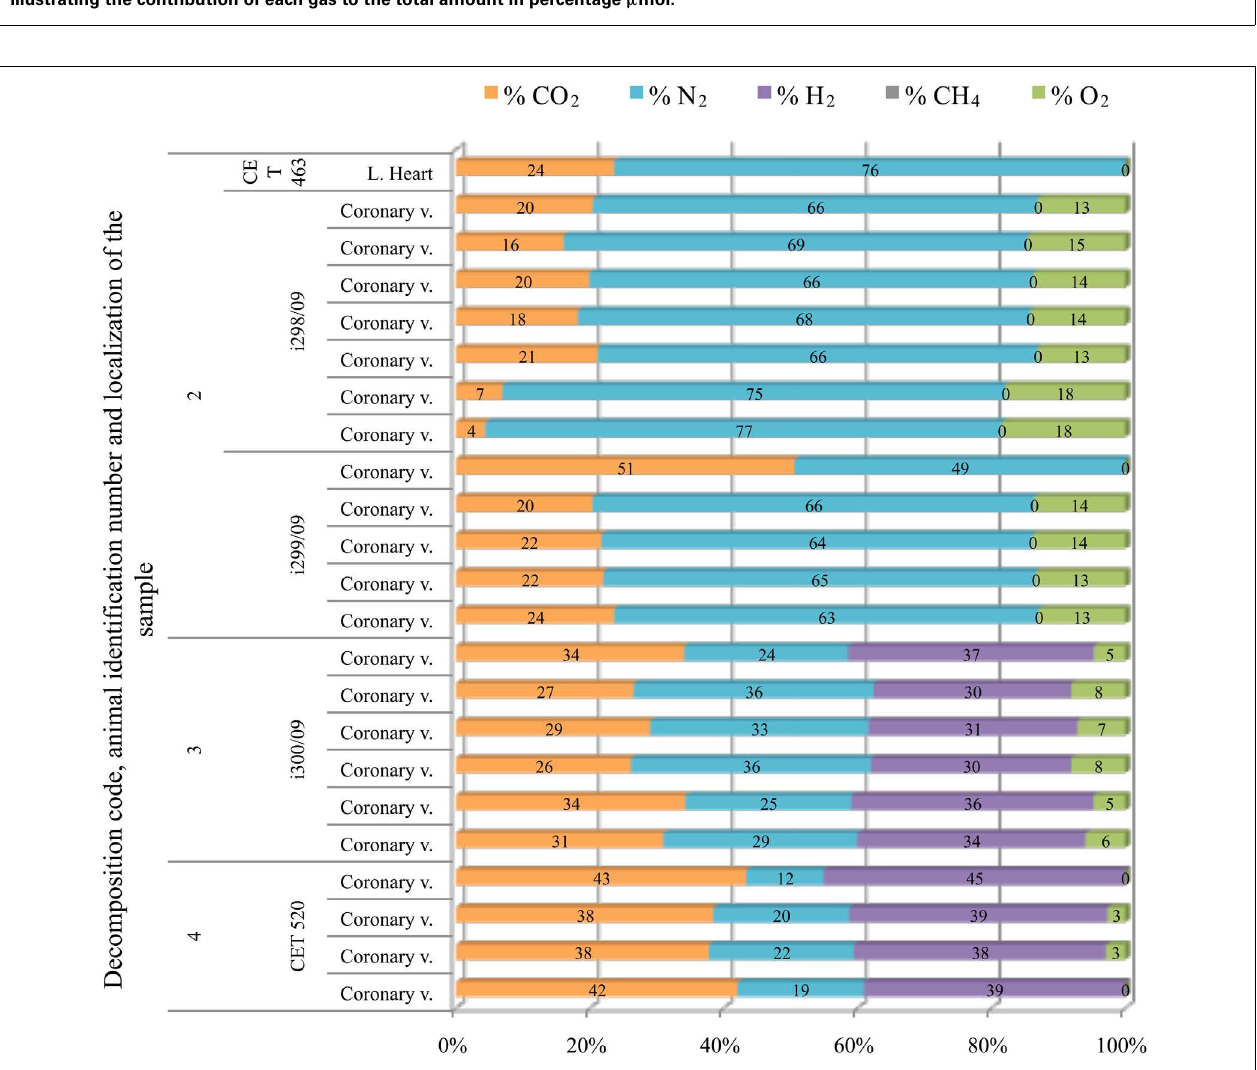
FIGURE 8 | Intravascular bubble’s gas composition of deep diving animals belonging to Physeteridae family in different tissues and decomposition codes, illustrating the contribution of each gas to the total amount in percentage μ mol.